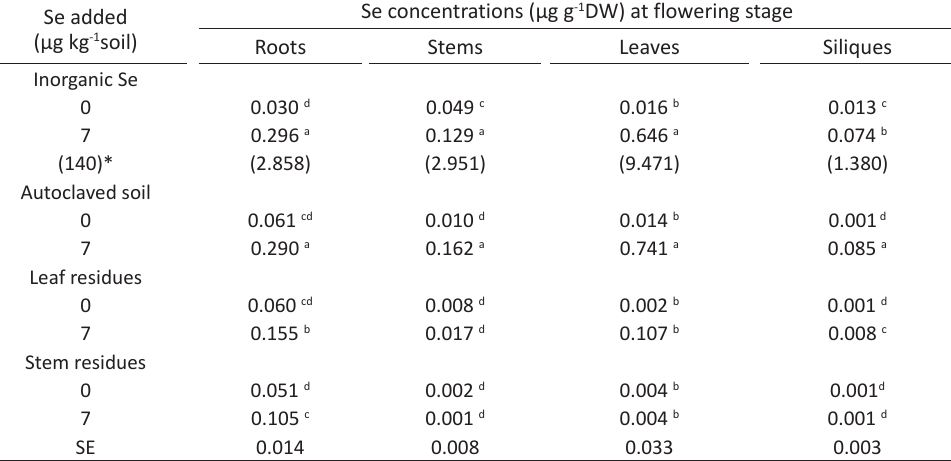
Table 5. Se concentration (µg g -1 DM in root, stem, leaves and the siliques of B. napus L. plants grown in soils treated with inorganic Se (0, 7 and 140 µg kg -1 soil), organic Se (leaf and stem residue, 0 and 7 µg kg -1 soil) and in autoclaved soil with inorganic Se (0 and 7 µg kg -1 soil) at the flowering stage. Se added (µg kg -1